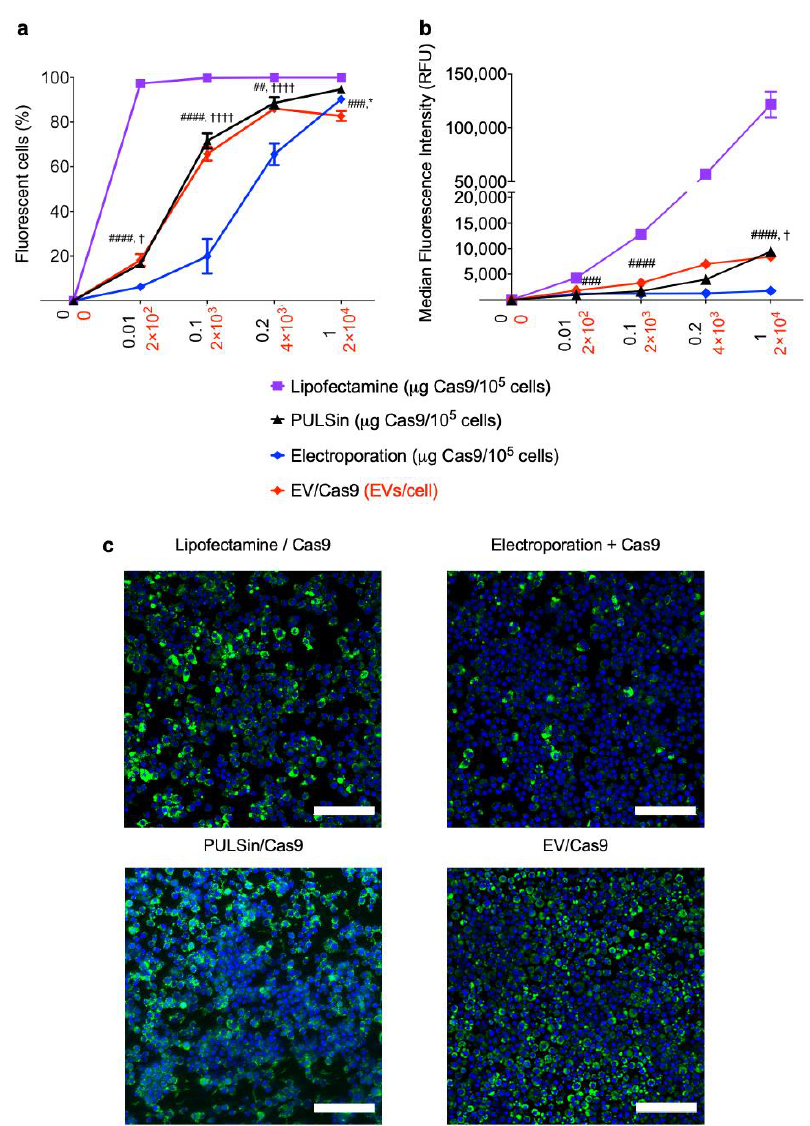
Figure 4. Comparison of EVs, electroporation and commercial protein transfection reagents for intracellular delivery of Cas9. Alexa Fluor 488-labeled Cas9 uptake in Raw 264.7 cells treated with commercial protein transfection reagents (PULSin or Lipofectamine CRISPRMAX Cas9), electroporation and EVs. ( a ) Percentage of fluorescent cells assessed by flow cytometry. ( b ) Median fluorescent intensity expressed in relative fluorescent units (RFU) assessed by flow cytometry. Measurements units for the x-axes are indicated in parenthesis after the sample name (black values indicate units for lipofectamine, PULSin and electroporation, while red values indicate units for EVs). Data in figure a and b are presented as mean ± SD of three replicates. ( c ) Confocal fluorescent microscopy images. Scale bars, 100 µ m. Statistical analysis was performed by two-way ANOVA with post-hoc pairwise comparisons using Tukey’s test. *, p < 0.05 in comparison to PULSin/Cas9. ##, p < 0.01; ###, p < 0.001; ####, p < 0.0001 in comparison to Lipofectamine/Cas9. †, p < 0.05; ††††, p < 0.0001 in comparison to electroporated